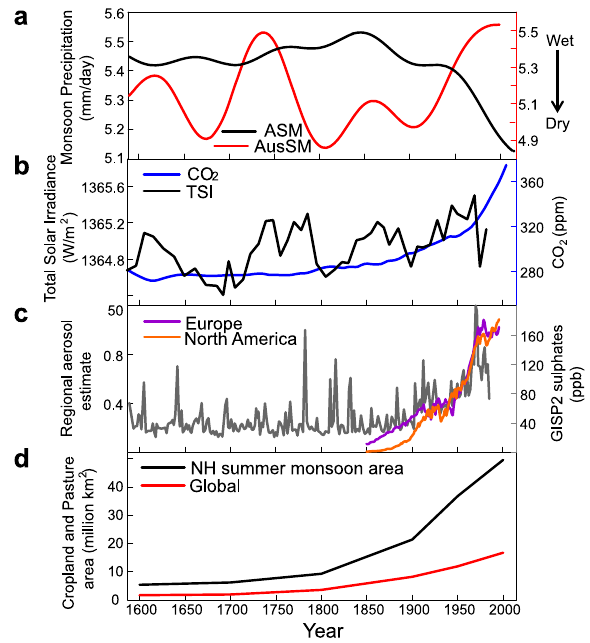
Fig. 6 Centennial variations of monsoon and external forcings. a Centennial variations of ASM (black line) and AusSM (red line) precipitation. b Time series of total solar irradiance (28, black line) and atmosphere CO 2 concentration (29, blue line). c Regional aerosol estimate (30, purple and orange lines) and GISP2 sulphates (31, gray line) in Greenland. d Northern Hemisphere summer monsoon (black line) and Global (red line) cropland and Pasture area 37